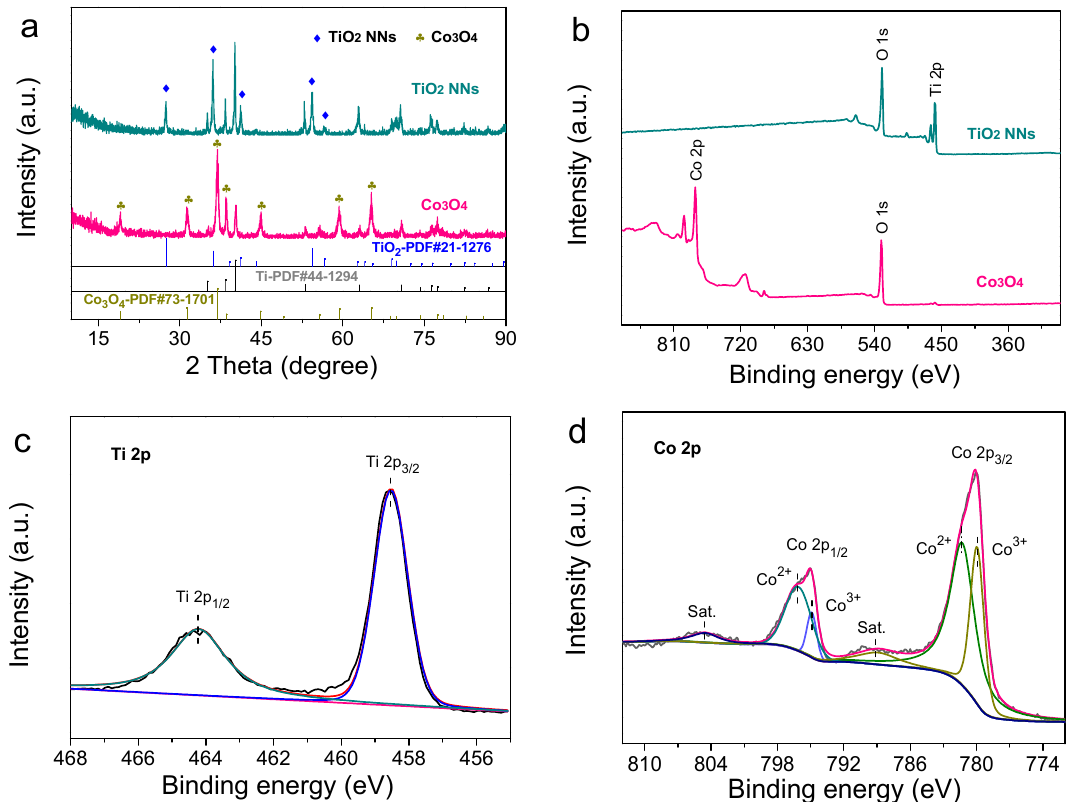
Figure 2. ( a ) XRD patterns of TiO 2 NNs, Co 3 O 4 . ( b ) The full XPS spectra recorded from the surface for TiO 2 NNs and Co 3 O 4 . High-resolution XPS spectra of Ti 2p ( c ) and Co 2p ( d ).